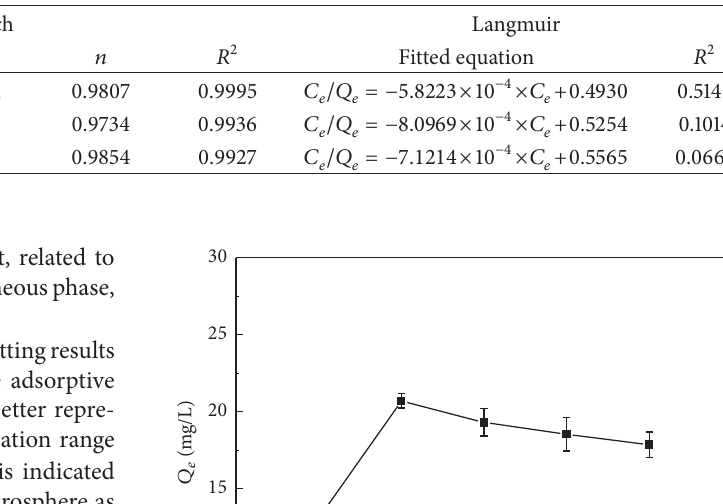
Table 2: Isotherms parameters of composite microsphere (CA4).